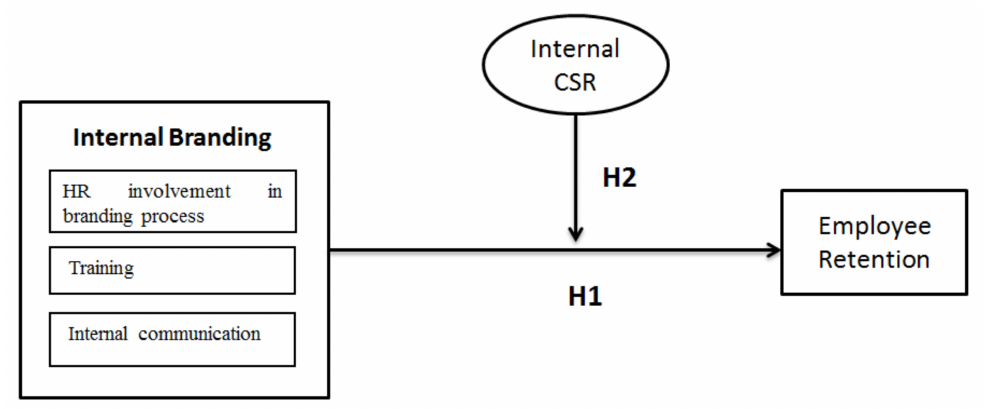
Figure 1. Conceptual model.